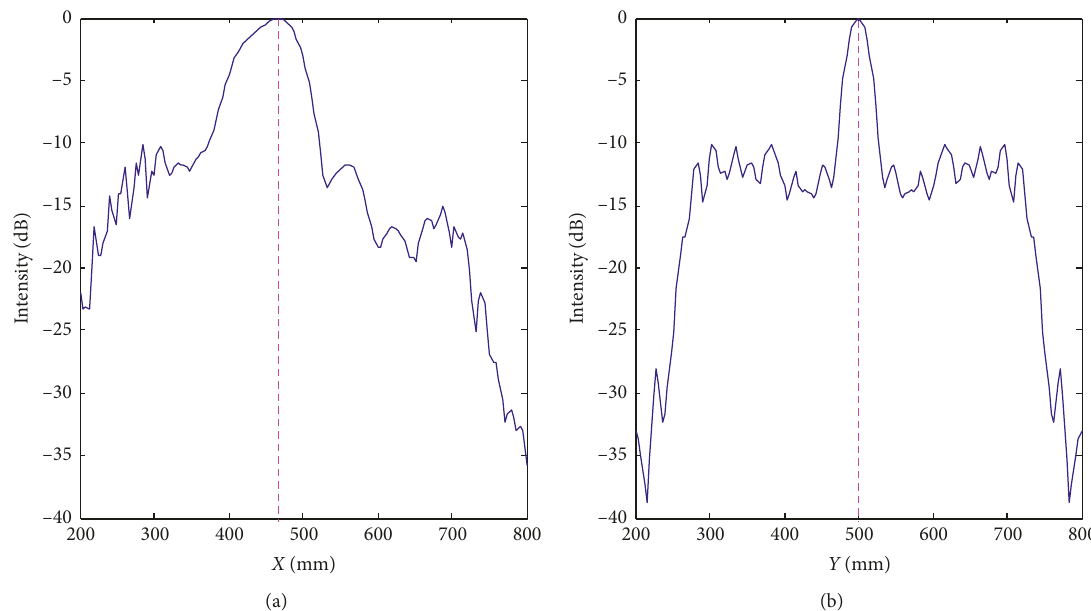
Figure 9: TDTE imaging intensity profile in (a) the X direction of the point (470mm, 500mm) and (b) the Y direction of the point (470 mm,